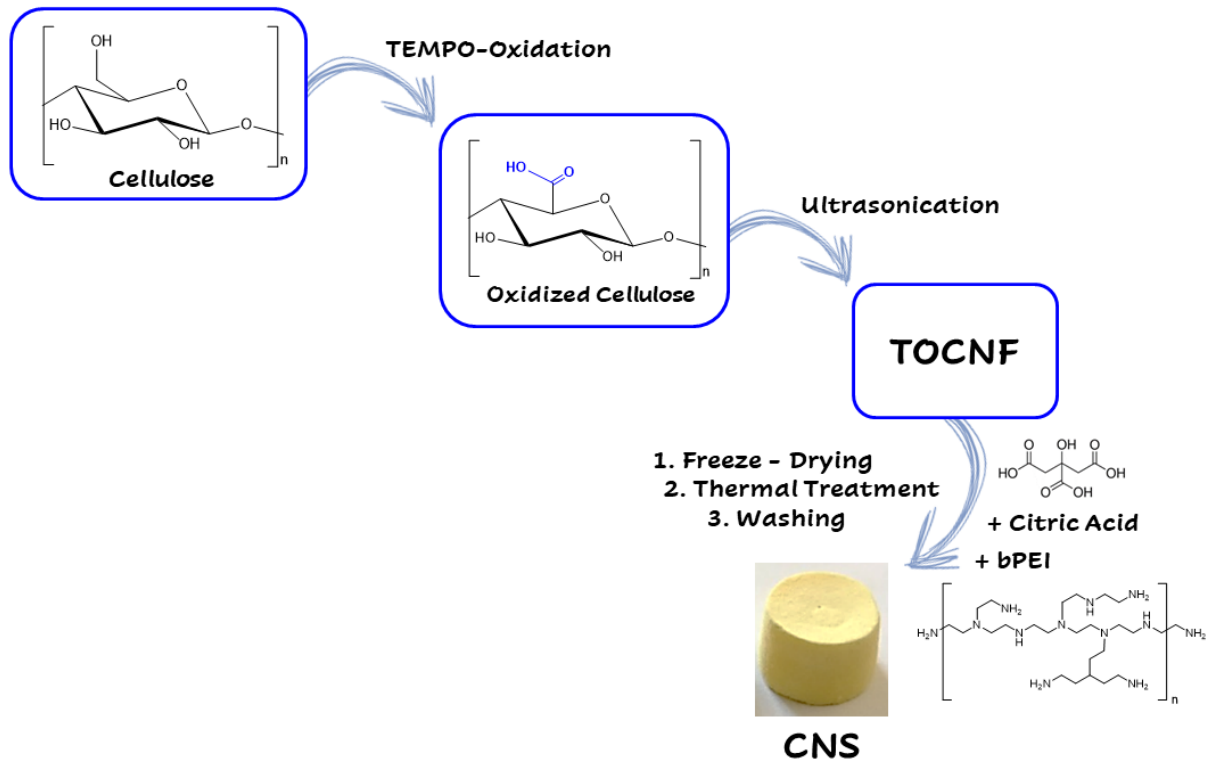
Figure 4. Synthetic steps in the synthesis of CNS (see text for description) .